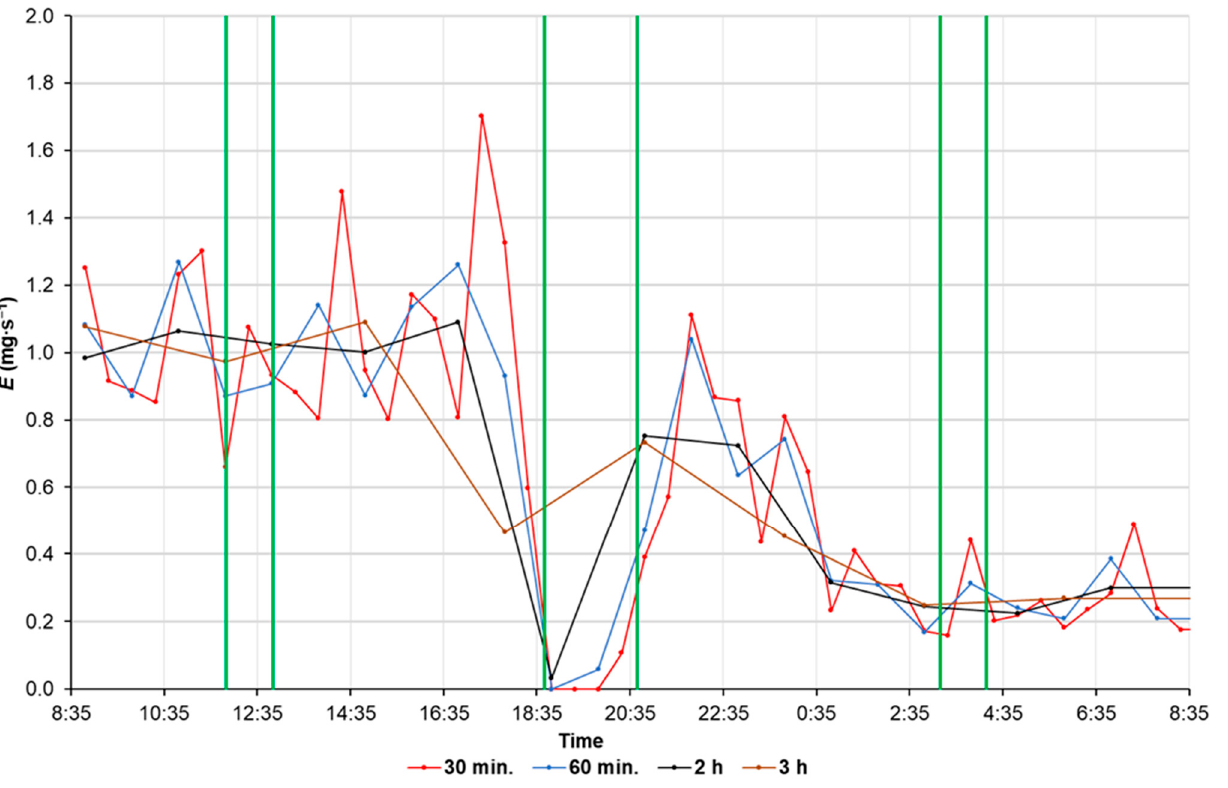
Figure 9. Dependence of the E value on time for different time window widths for artificially modified model data (the vertical green lines indicate artificially modified intervals).